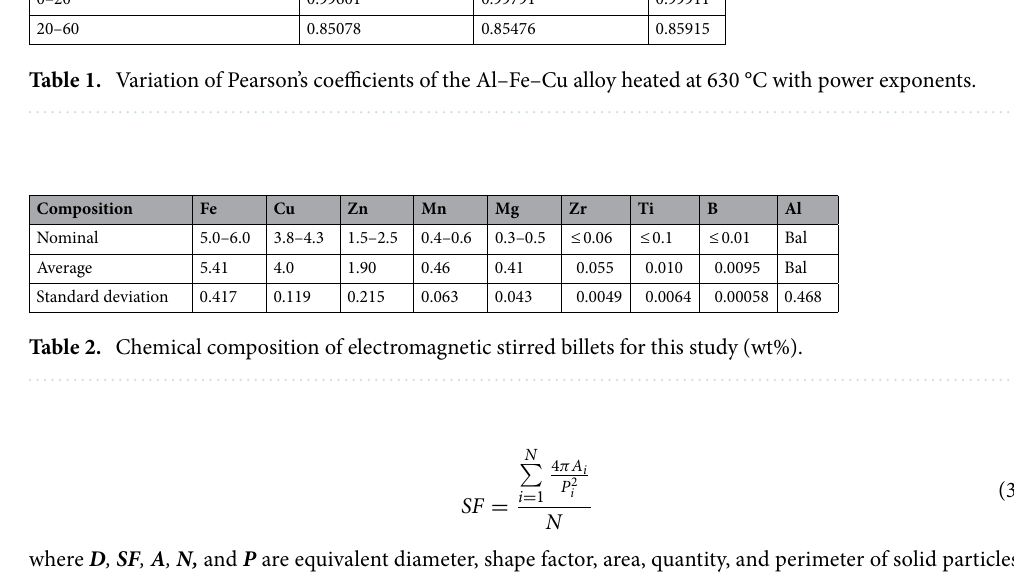
Soaking time (min)